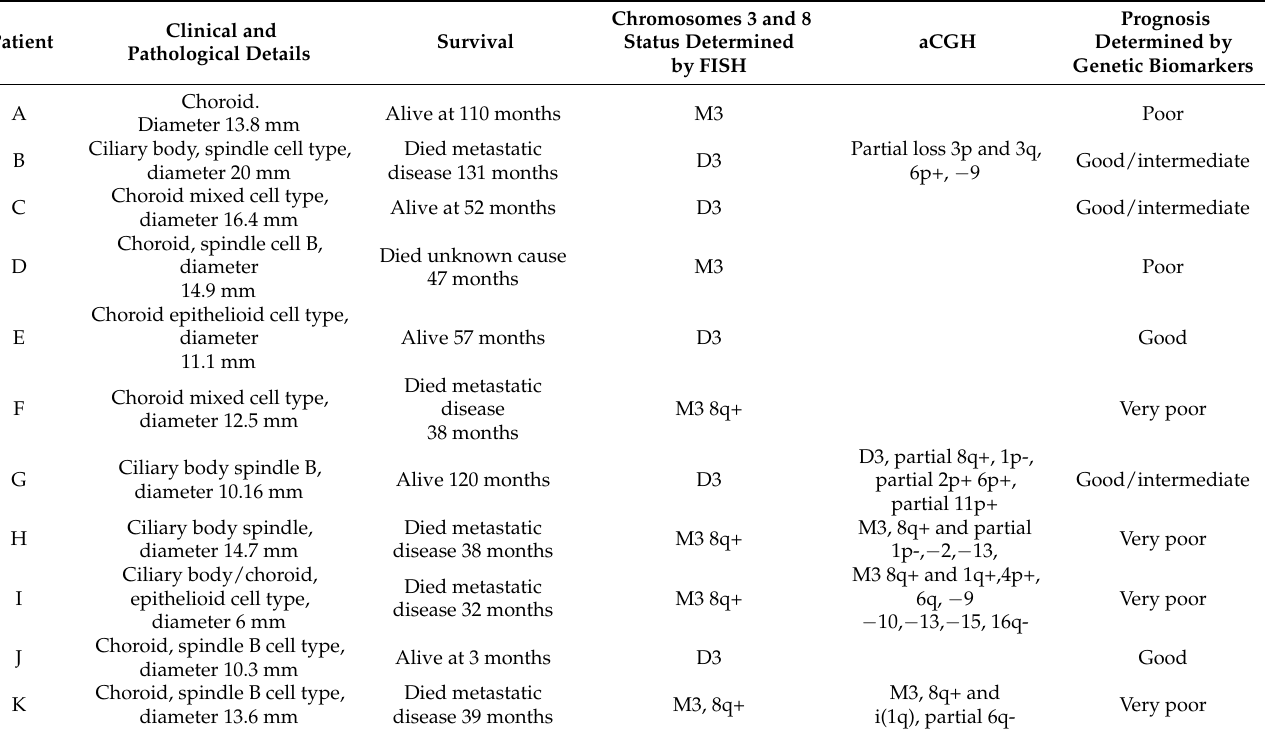
Table 1. Clinical pathological details of the 11